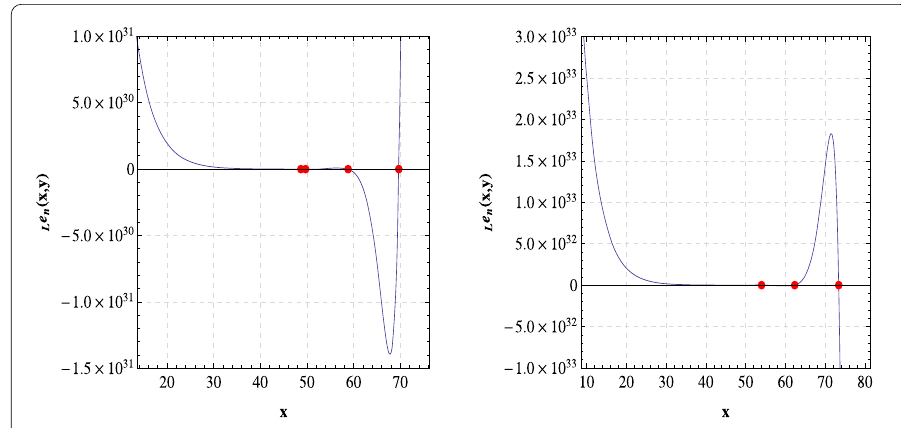
Figure 3 Graph of L e 20 ( x , y ) and L e 21 ( x , y ) along with their real zeros